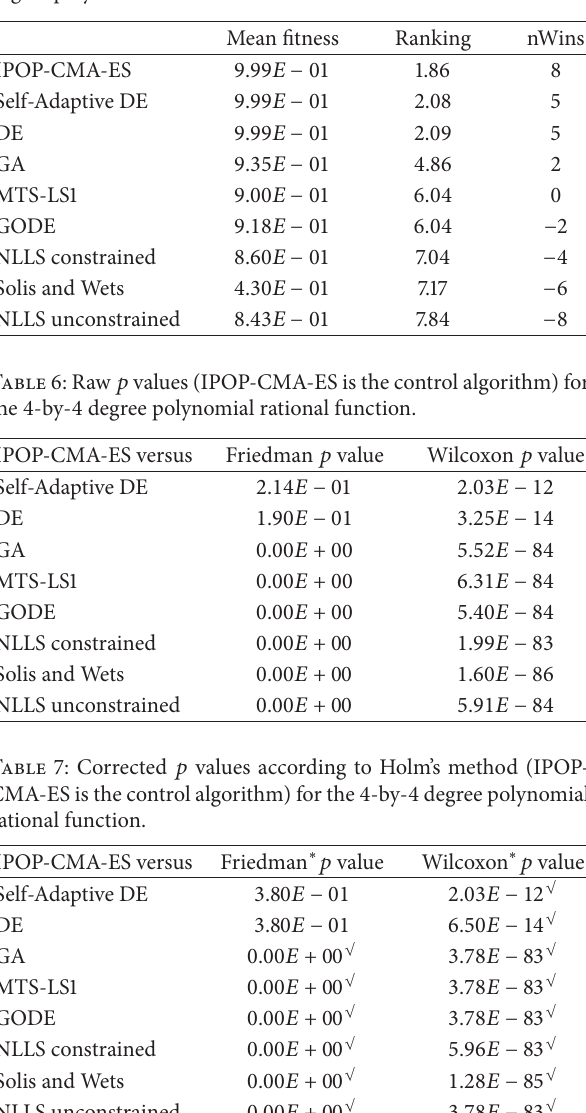
Table8:Meanfitness,averageranking,andnumberofwins(nWins) in pair-wise comparisons with the other algorithms on the 8-term Fourier series.